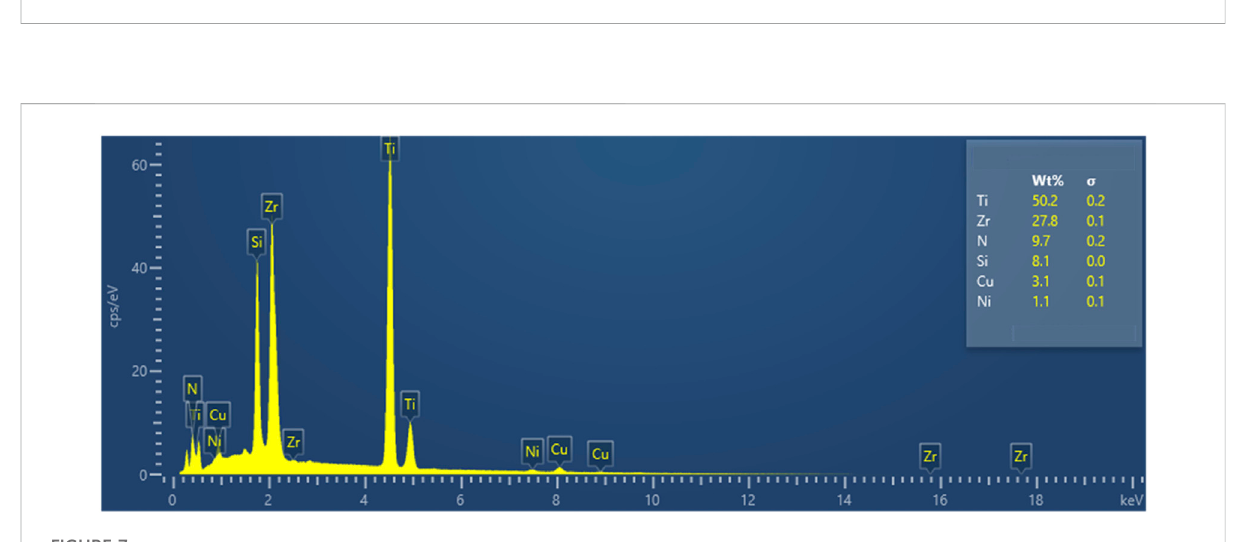
FIGURE 7 The Energy Dispersive Spectrometer (EDS) analysis results of the brazed